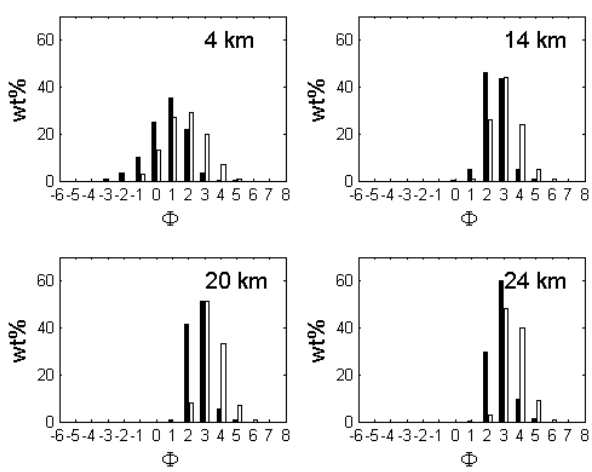
Fig. 5. Comparisons between the observed grain-size distribution of Figure 5. Comparisons between the observed grain-size distribution of the tephra deposit 636 the tephra deposit (black) associated with the 21–24 July eruption (black) associated with the 21-24 July eruption of Etna and grain-size distribution computed 637 of Etna and grain-size distribution (grey) computed at the same lo- (grey) at the same location. Field data were collected respectively at about 4, 14, 20, 24 km 638 cation. Field data were collected respectively at about 4, 14, 20, and from the volcanic vent. 639 24km from the volcanic vent.